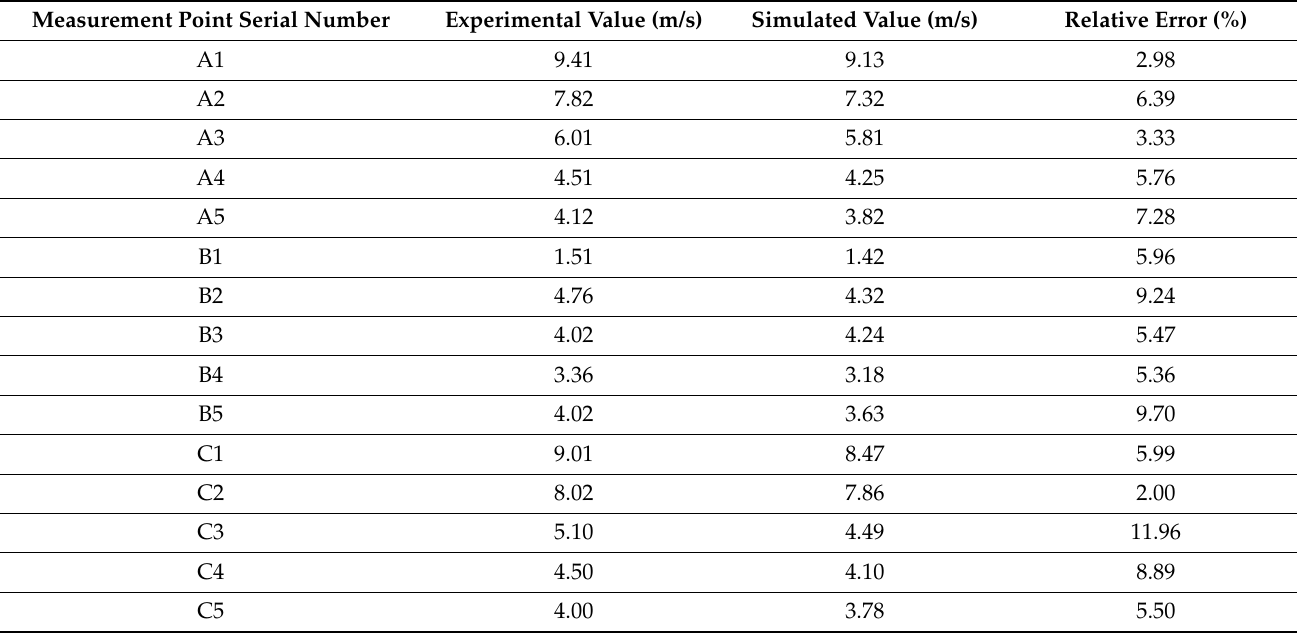
Table 3. Experimental and simulated values of z-direction velocity of measurement points.